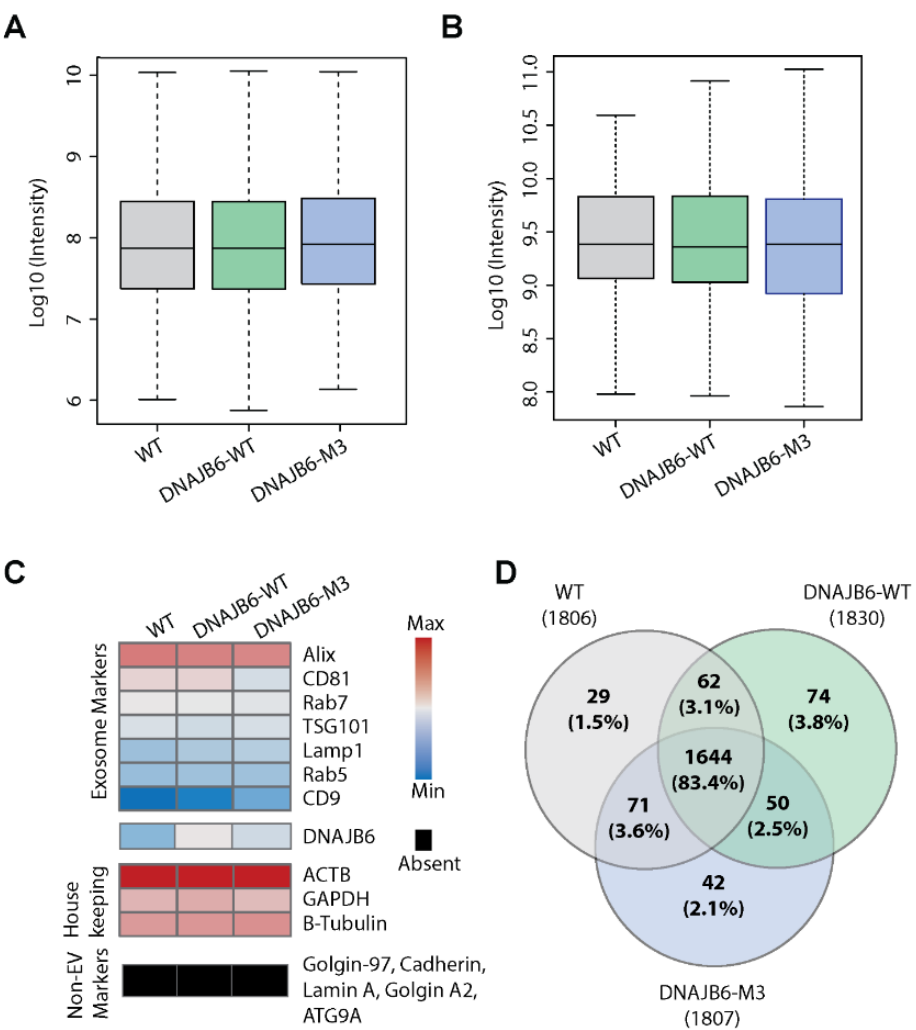
Figure 4. WT, DNAJB6 ‐ WT, and DNAJB6 ‐ M3 EVs show similar proteomes. ( A ) Comparative analysis based on total intensity values of protein datasets in WT, DNAJB6 ‐ WT, and DNAJB6 ‐ M3 EVs. ( B ) Comparative analysis based on intensity values of top 100 EV marker proteins from ExoCarta database. ( C ) Intensity heatmap for representative EV marker, non ‐ EV specific proteins, housekeeping proteins, and DNAJB6. ( D ) Venn diagram of proteins found specifically in WT, DNAJB6 ‐ WT, and DNAJB6 ‐ M3 EVs.